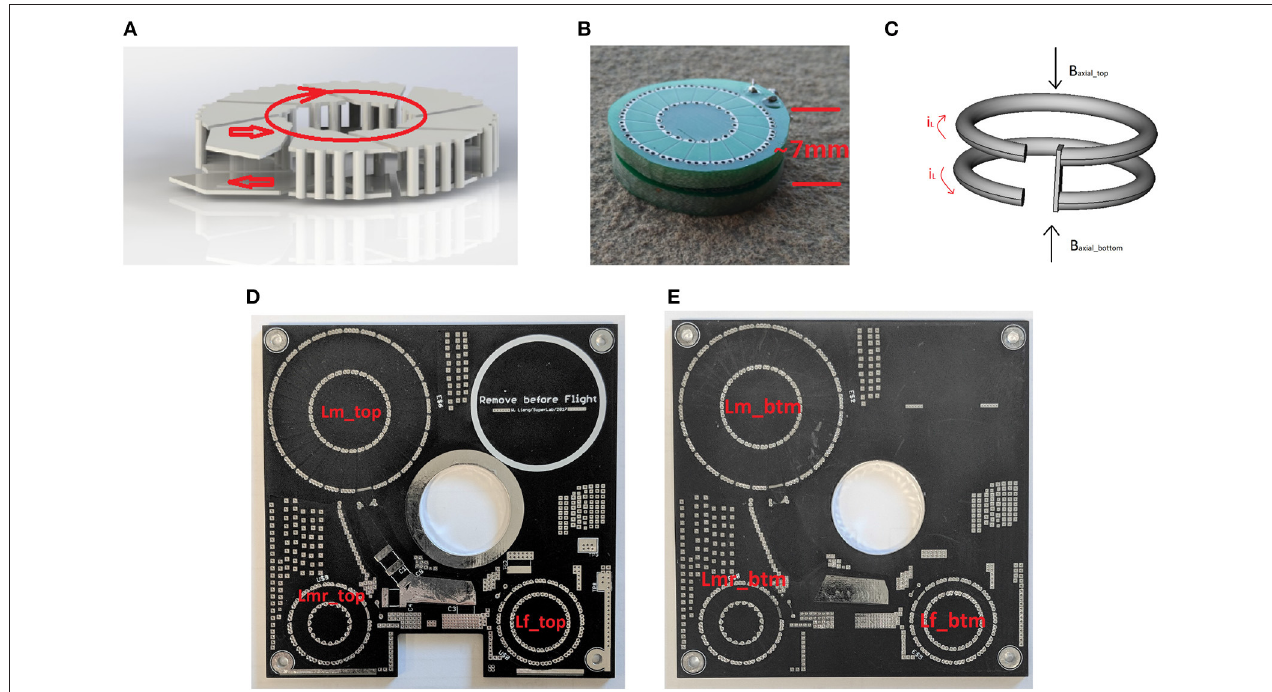
FIGURE 2 | Class 8 2 inverter and matching network PCB design with all air core inductors printed on PCB. The stacking of the top and bottom board allows cancellation of axial flux form each toroidal inductor and mitigates EMI issue. (A) Schematics of the PCB toroidal air core inductor. The top and bottom of the toroid are copper planes on PCB and the vertical connections are made through vias. Note that as the current enters and exits at the toroid’s two terminals, it creates a circumferential current path as indicated in the figure. The circumferential current induces axial flux outside the torus. (B) By vertically stacking two PCB toroidal inductors with the same dimensions and turns but opposite winding directions, the axial flux of the two toroids cancels and therefore mitigates EMI issue. The top and bottom toroids can be connected either in series or in parallel. (C) A simple schematic illustrates the axial flux cancelation effect. (D) Top half of the power inverter printed on a 3.2 mm thickness PCB. Note that not only a single inductor can be implemented with the stacking approach but also the whole inverter. This allows the axial flux cancelation of all the toroidal inductors in the inverter. (E) Bottom half of the power inverter printed on a 3.2 mm thickness PCB. Note that not only a single inductor can be implemented with the stacking approach but also the whole inverter. This allows the axial flux cancelation of all the toroidal inductors in the